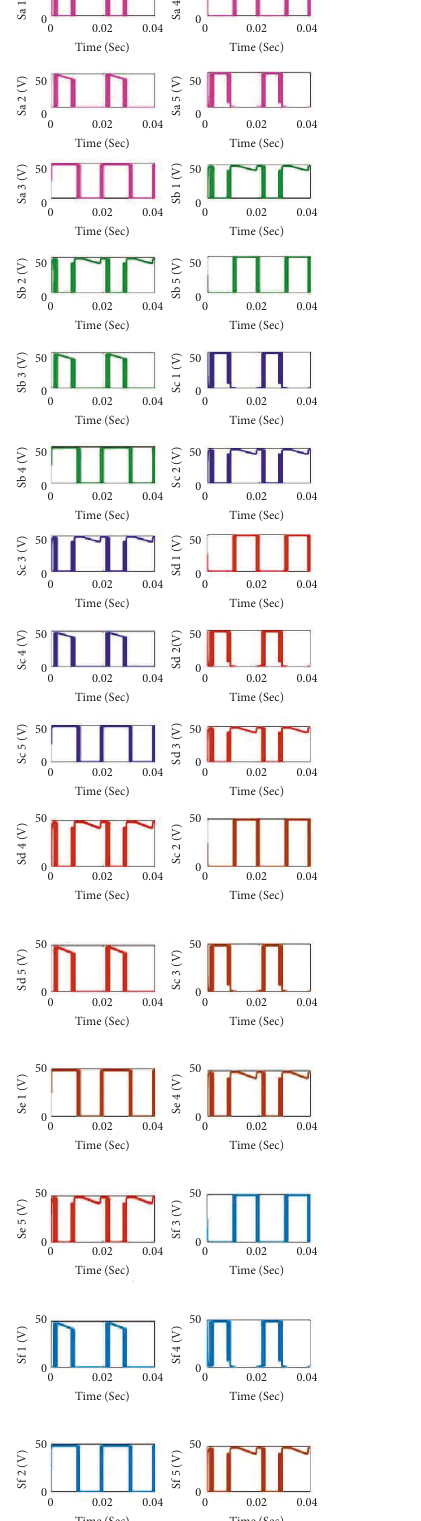
Table 2: Specifications for the proposed inverter.